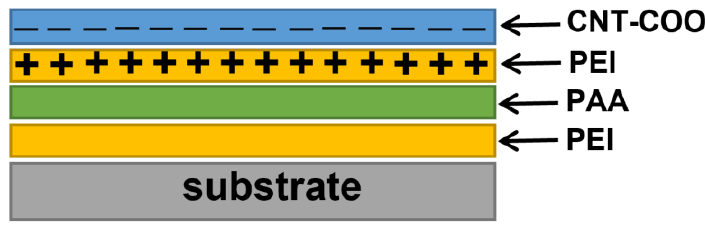
Figure 1. Schematic representation of the PEI+SWCNT-COOH structure. Fabricated samples were examined by Raman spectroscopy. Raman spectra were measured using a Thermo Scientific (Waltham, MA, USA) DXR Raman microscope with a green laser ( λ = 532 nm) and a red laser (780 nm) at a power of 8 mW. The expositions during the registration of the spectrum consisted of 10 expositions per 20 s, with 10× mag- nification. Spectroscopic analysis (UV-Vis (Jasco V-750) and FTIR (Thermo Scientific NicoletiS20) spectrophotometer) was used to investigate transparency in the UV-Vis and mid-IR spectra range. FTIR measurements were carried out in the wavelength range of 2500 – 3500 nm, with a resolution of 4 cm −1 and 32 scans. The sheet resistance of the films was measured by a sheet resistance multimeter (Hewlett Packard, Palo Alto, CA, USA, 3457A). 2.2. Computational Details The computational analysis of interactions between SWCNT-COOH and solvent molecules was performed by applying the density functional theory (DFT) and density functional tight-binding (DFTB) methods. The DFTB method was used to geometrically optimize very large systems (consisting of more than 300 atoms) and calculate binding energies. In the case of the DFTB calculations, the Hamiltonian based on the extended tight-binding (xTB) model combined with the GFN1-xTB parametrization was applied. This type of approach, developed by Grimme and coworkers [39], offers a wide coverage of elements compared to other model Hamiltonians. Binding energies were based on DFTB calculations according to the following equation: 𝐸 𝑏 = 𝐸 𝑡𝑜𝑡 (𝑆𝑊𝐶𝑁𝑇 − 𝐶𝑂𝑂𝐻 + 𝑠𝑜𝑙𝑣𝑒𝑛𝑡 𝑚𝑜𝑙𝑒𝑐𝑢𝑙𝑒) − 𝐸(𝑆𝑊𝐶𝑁𝑇 − 𝐶𝑂𝑂𝐻) −𝐸(𝑠𝑜𝑙𝑣𝑒𝑛𝑡 𝑚𝑜𝑙𝑒𝑐𝑢𝑙𝑒),